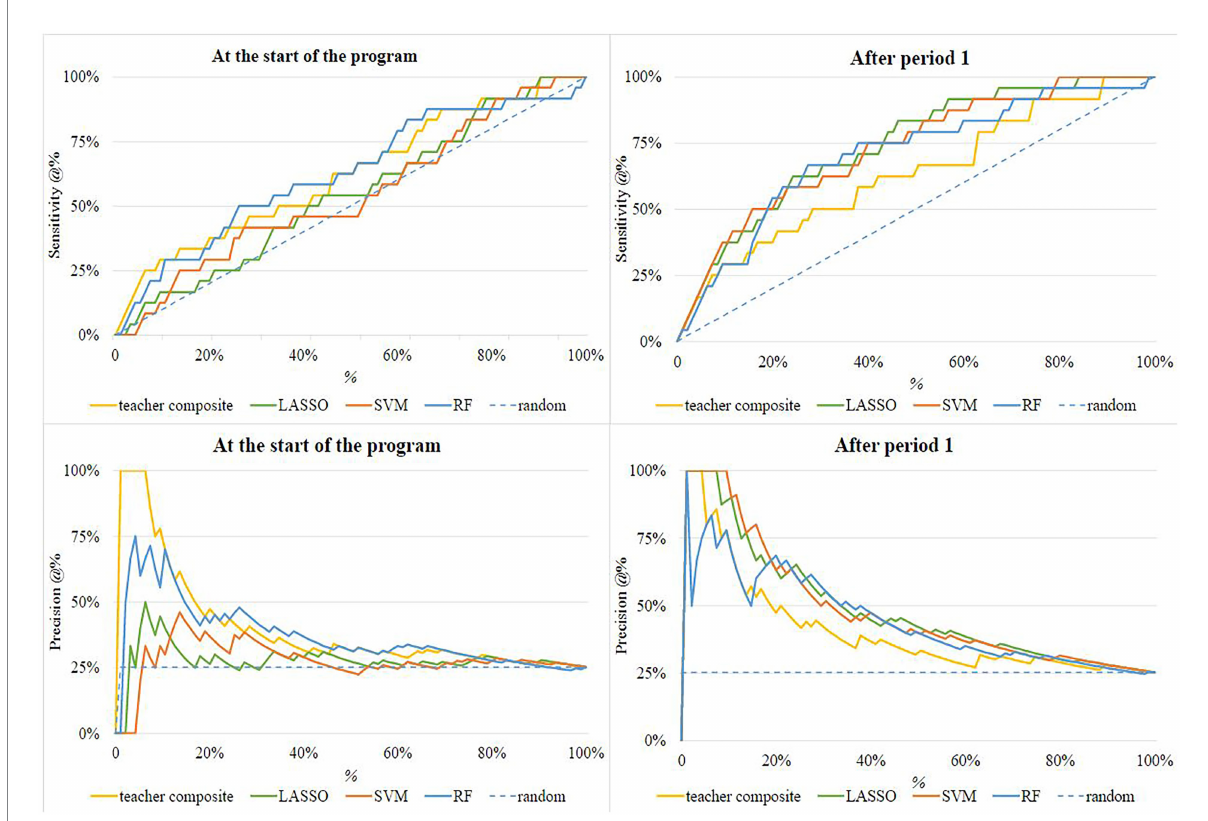
FIGURE 2 Sensitivity and Precision @% at the start of the program and after period 1. The dashed line represents the sensitivity with random invitation.